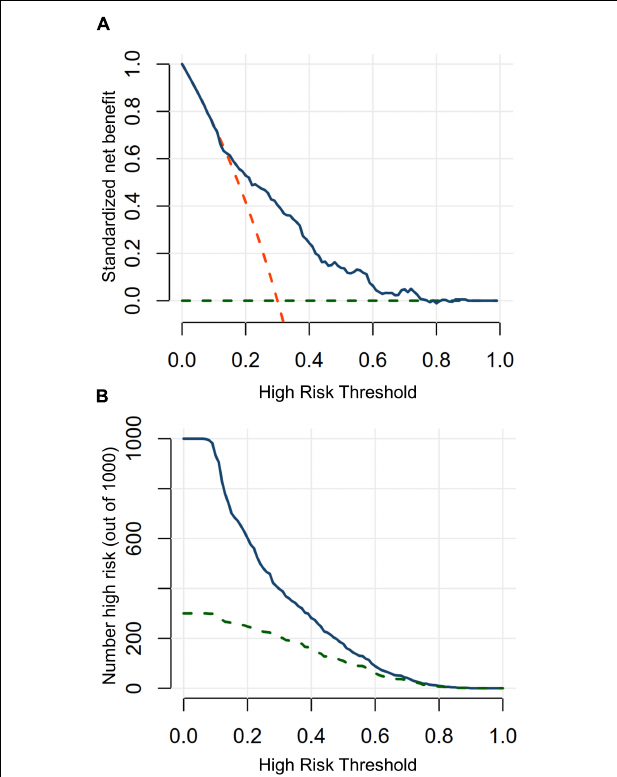
FIGURE 6 | Decision curve analysis and clinical impact curve in testing in testing dataset. (A) Decision curve analysis. When a threshold probability is ranged from 15 to 80%, using the nomogram to predict CA-AKI achieves more benefits than the treat-all-patients scheme or the treat-none scheme. Blue solid line indicates the nomogram; red dashed line, the assumption that all patients have CA-AKI; green dashed line, the assumption that no patients have CA-AKI. (B) Clinical impact curve. Clinical impact curves analysis predicted the probability stratification of 1,000 subjects by using resample bootstrap method. The number of high-risk patients identified by nomogram (blue solid line) and high-risk patients with CA-AKI occurrence (green dashed line) were depicted in the plot under each threshold